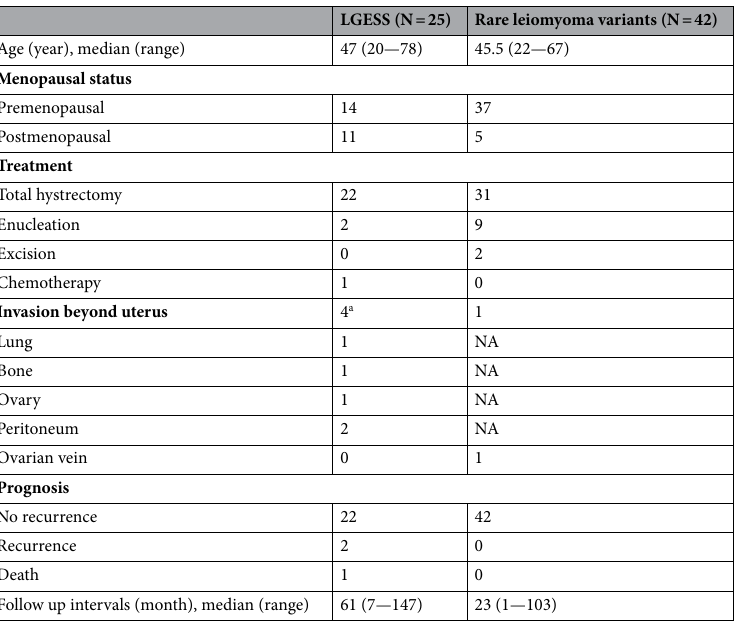
Table 1. Patient characteristics. LGESS low grade endometrial stromal sarcoma. a One case had ovarian metastasis and peritoneal